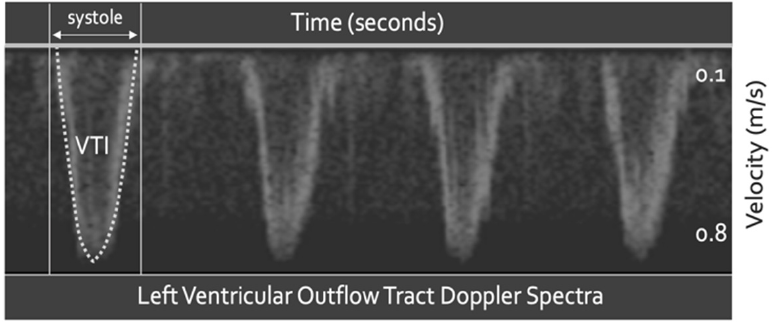
Figure 2. Doppler ultrasound of the left ventricular outflow tract; 4 cardiac cycles obtained via transesophageal echocardiography. The dotted trace is the maximal velocity and the area under that trace is the velocity time integral (VTI).